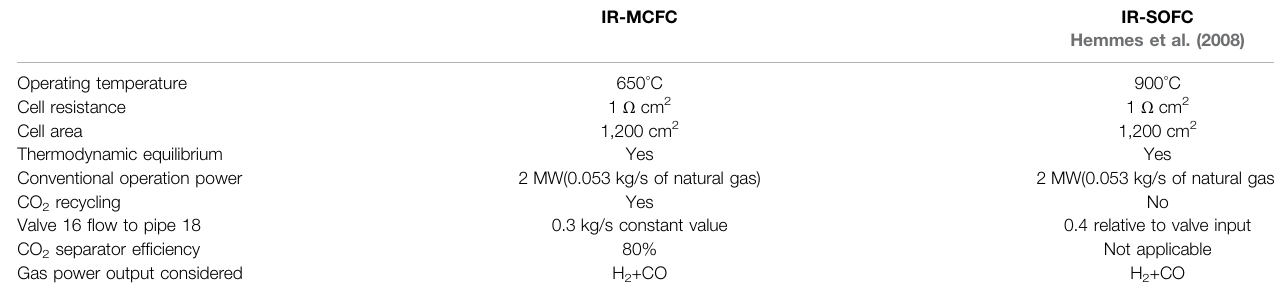
TABLE 1 | Summary of assumptions made in this MCFC